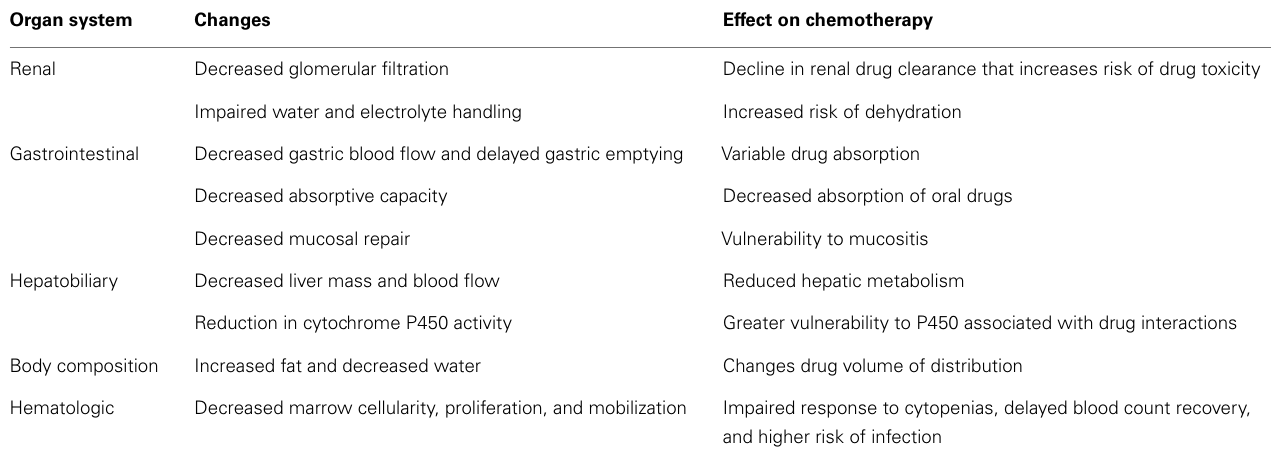
Table 1 | Physiologic changes with aging